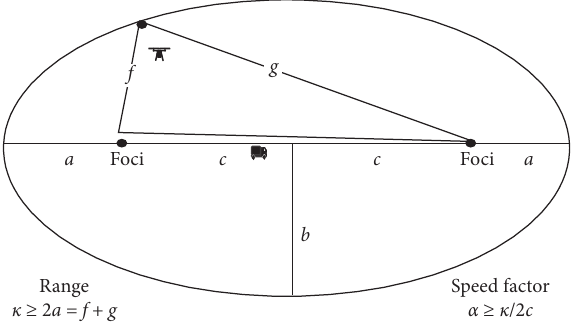
Figure 4: Example of truck-drone delivery inside an